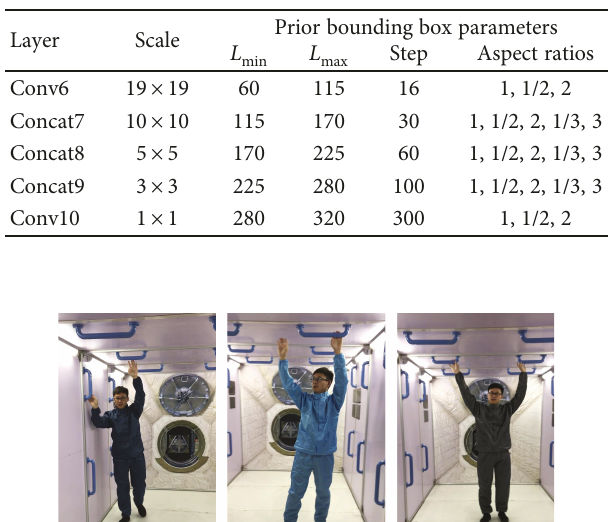
Figure 6: Prior bounding boxes and proposals on the main prediction layers. Table 1: Parameters of prior bounding boxes in each prediction layer.